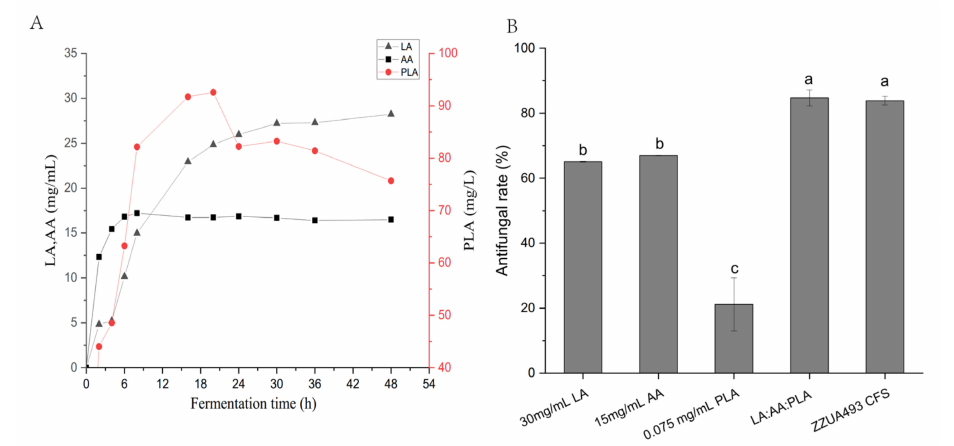
Figure 6. The organic acid production curve of ZZUA493 ( A ). The antifungal rate of LA, AA, PLA and their mixtures and CFS ( B ). Values with different superscript lowercase letters show significant differences among treatments ( p < 0.05). LA, lactic acid; AA, acetic acid; PLA, phenyllactic acids. LA: AA: PLA, the mixtures of 30 mg/mL LA, 15 mg/mL AA and 0.075 mg/mL PLA; CFS, cell-free